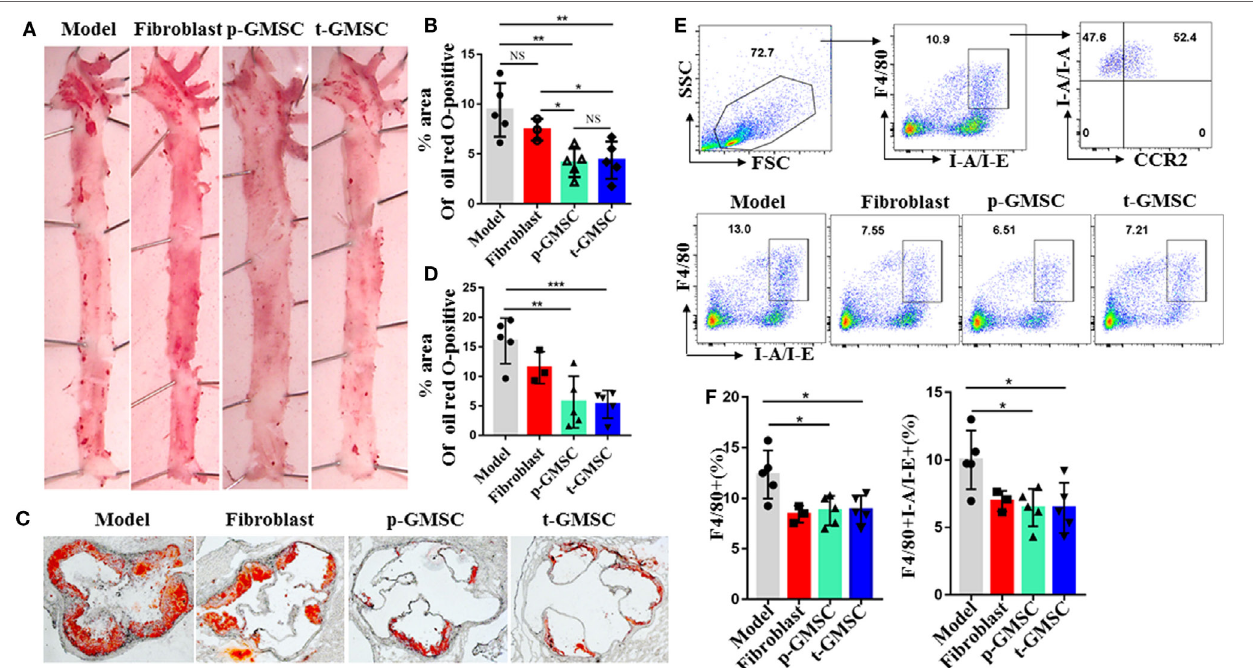
FigUre 1 | Systemic administration of human gingiva-derived mesenchymal stem cell (GMSC) accelerates atherosclerosis and reduce the number of macrophages in ApoE − / − mice. Mice consuming a high fat diet pre-treated with GMSC (p-GMSC, n = 5), treated with GMSC 4 weeks after a high fat diet (t-GMSC, n = 5), treated with fibroblast (fibroblast, n = 3), or treated with PBS (model, n = 5) were sacrificed on 10 weeks after a high fat diet. (a,B) Representative images of Oil Red O (ORO) stained on the face aortic preparations. The bar graphs show the mean ± SD. (c,D) Representative images of ORO-stained aortic root sections. The bar graphs show the mean ± SD. Scale bar = 250 µm. (e,F) Splenocytes were stained with anti-F4/80, -I-A/I-E, and -CCR2 mAbs. Living cells were gated to determine percentages of F4/80 + I-A/I-E + macrophages. Representative dot plots of individual mice from each group were depicted. The bar graphs show the mean ± SD. * p < 0.05; ** p < 0.01; *** p < 0.001. NS, p >